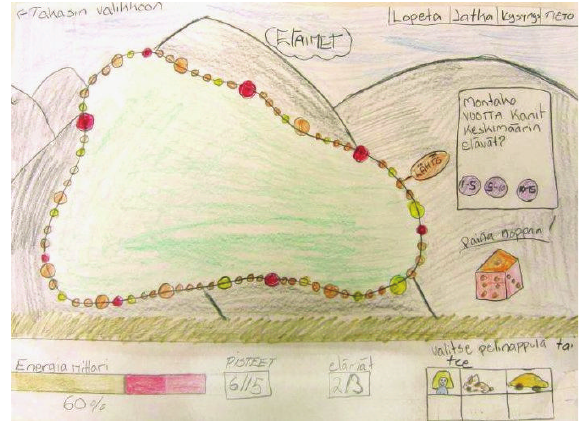
Figure 1: An example of the user interface